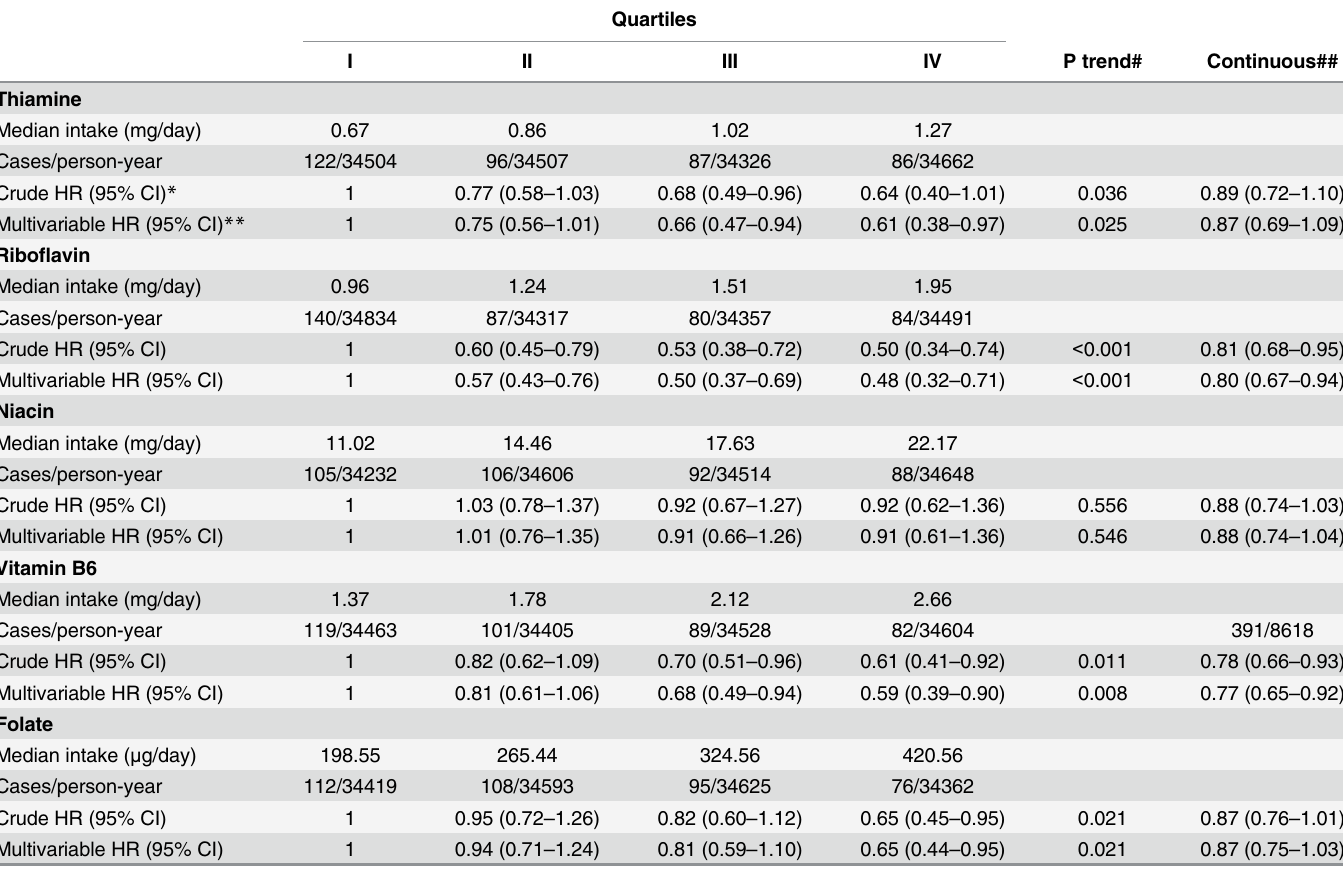
Table 2. HRs (95% CIs) of breast cancer in relation to quartiles of B vitamin intake in ORDET